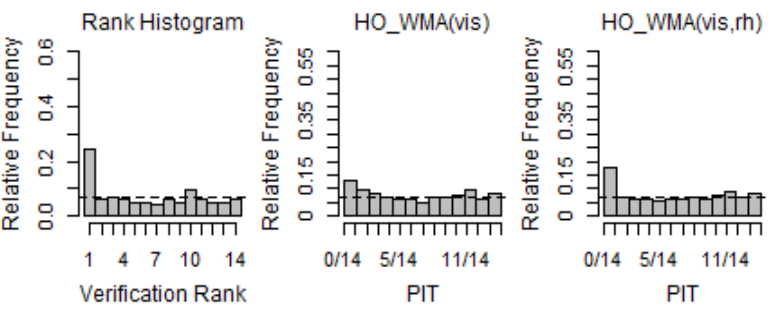
Figure 6. Verification rank histogram of raw ensemble forecasts and PIT histograms of WMA models for Station 182 (2018–19 DJF).